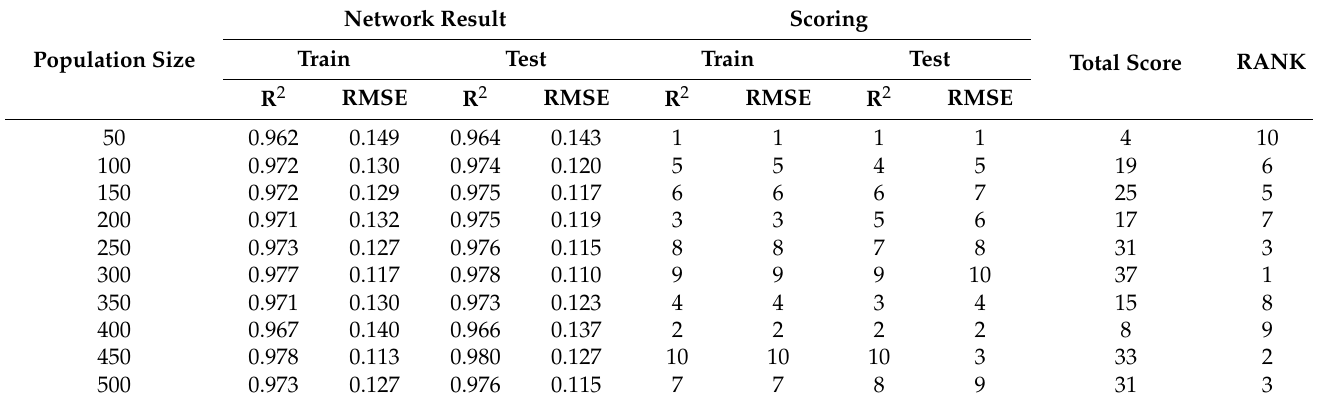
Table 1. The network results for the MVO-MLP.